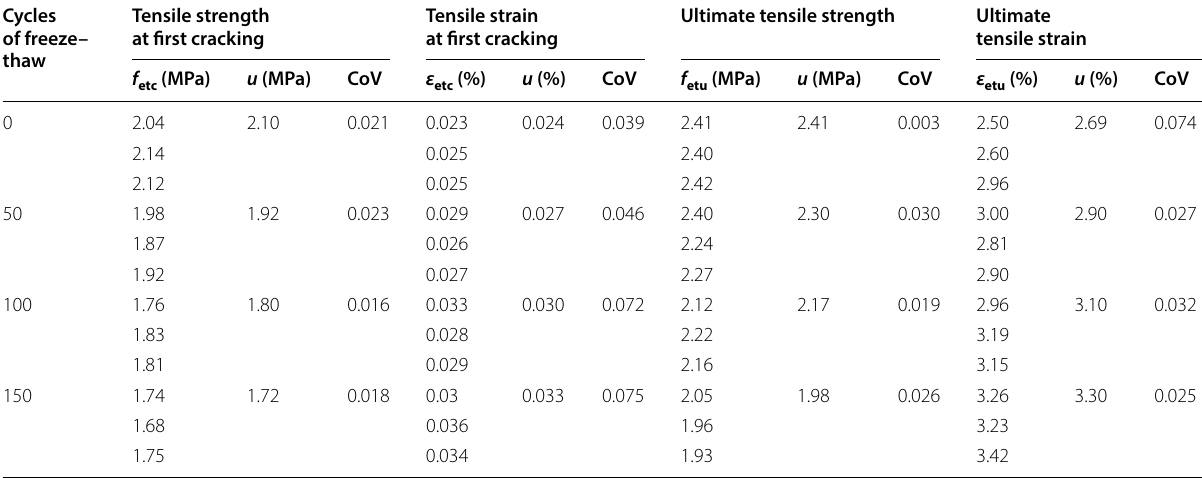
Table 3 Tensile properties of ECC rectangular flat-plates.